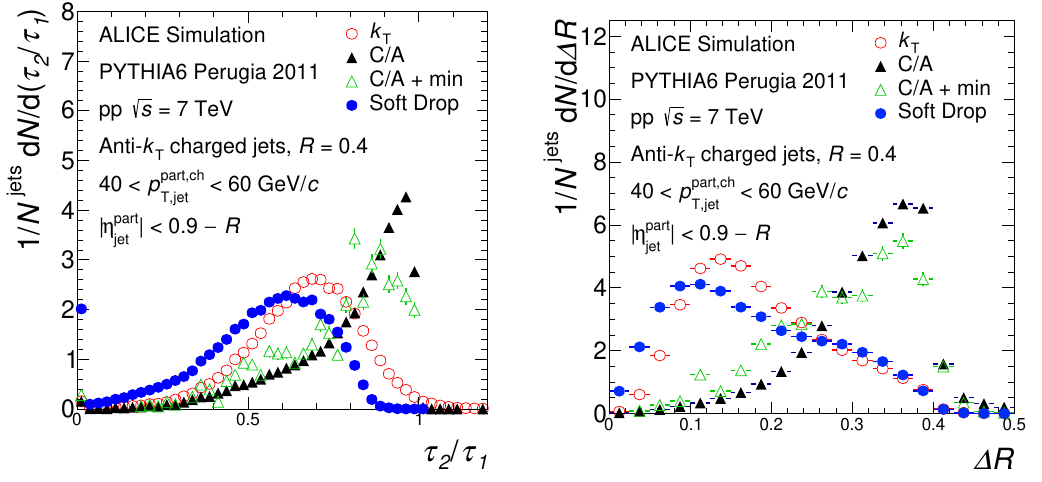
Figure 1 . The τ 2 /τ 1 (left) and ∆ R (right) observables are shown for a variety of different axis selection algorithms. Both plots are obtained using a PYTHIA6 Perugia 2011 simulation of pp √ collisions at s = 7 TeV, in the particle level charged jet transverse momentum interval of 40 ≤ p part , ch T ,